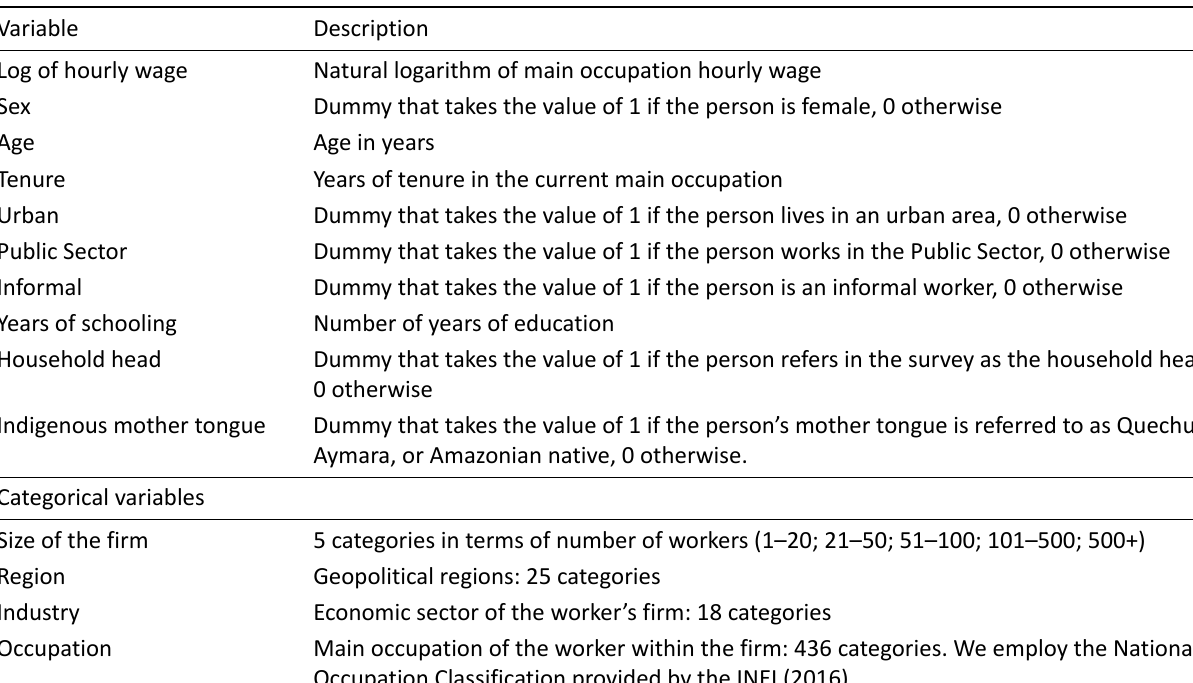
Table 1. Variables description.